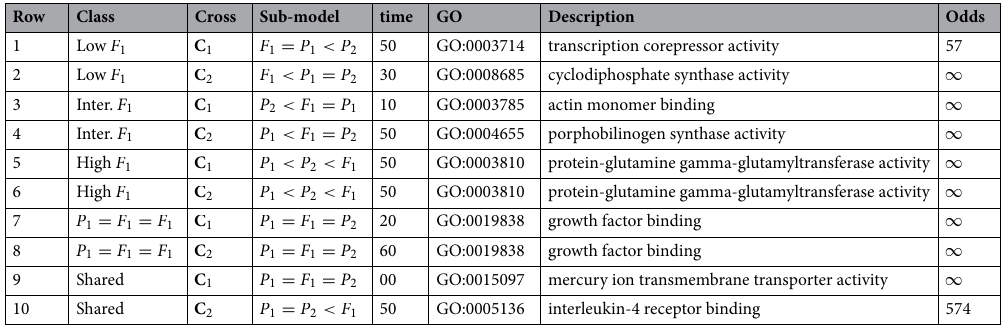
Row Class time GO Description